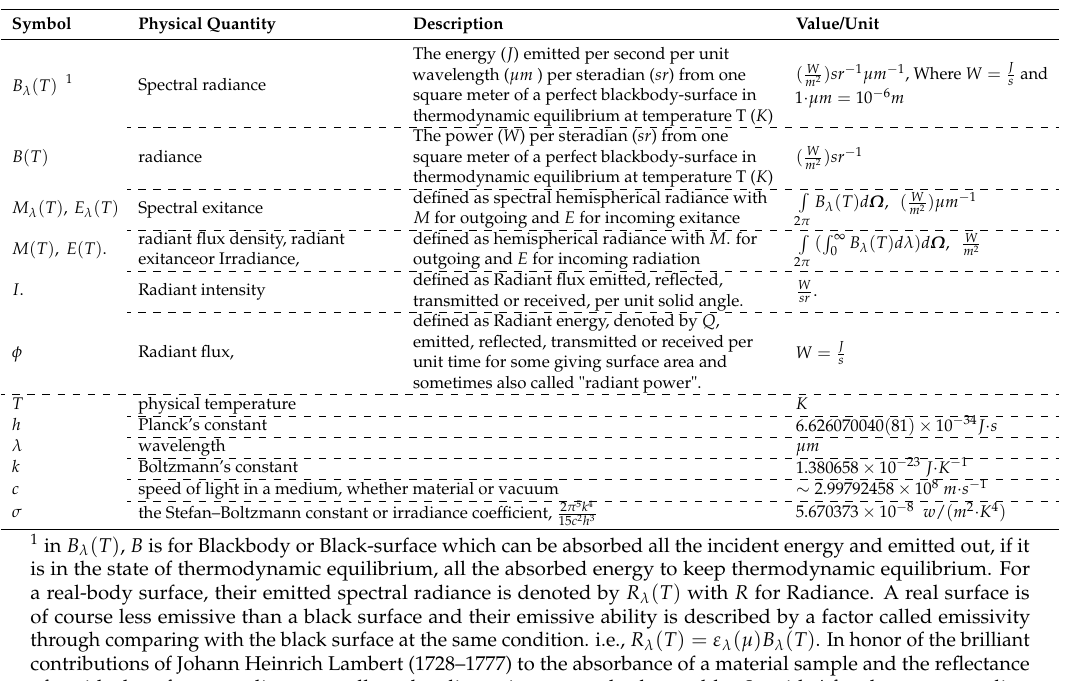
Table A2. Summarize of the quantities involved in the Planck’s function and its derivational equations involved in IR radiometry. Physical Quantity Description Value/Unit The energy ( J ) emitted per second per unit wavelength ( µ m ) per steradian ( sr ) from one Spectral radiance square meter of a perfect blackbody-surface in thermodynamic equilibrium at temperature T ( K ) The power ( W ) per steradian ( sr ) from one radiance square meter of a perfect blackbody-surface in thermodynamic equilibrium at temperature T ( K ) defined as spectral hemispherical radiance with M for outgoing and E for incoming